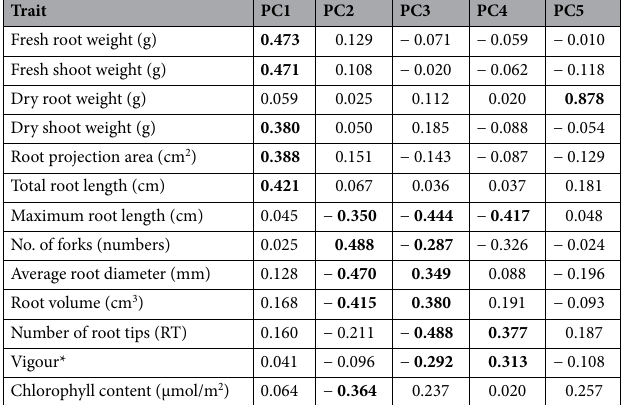
Table 3. Trait contribution towards principal component for root and shoot traits in 71 maize inbreds under water deficit condition. Significant values are in [bold].